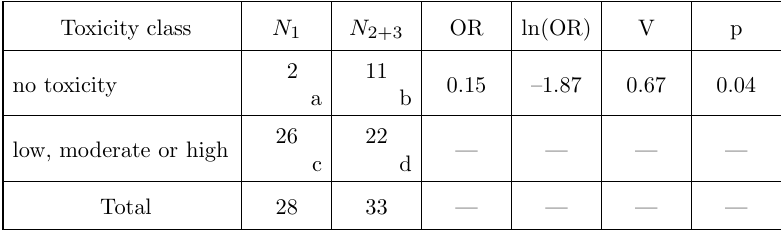
Table 4. Odds ratios (OR) for the first partial criterion under